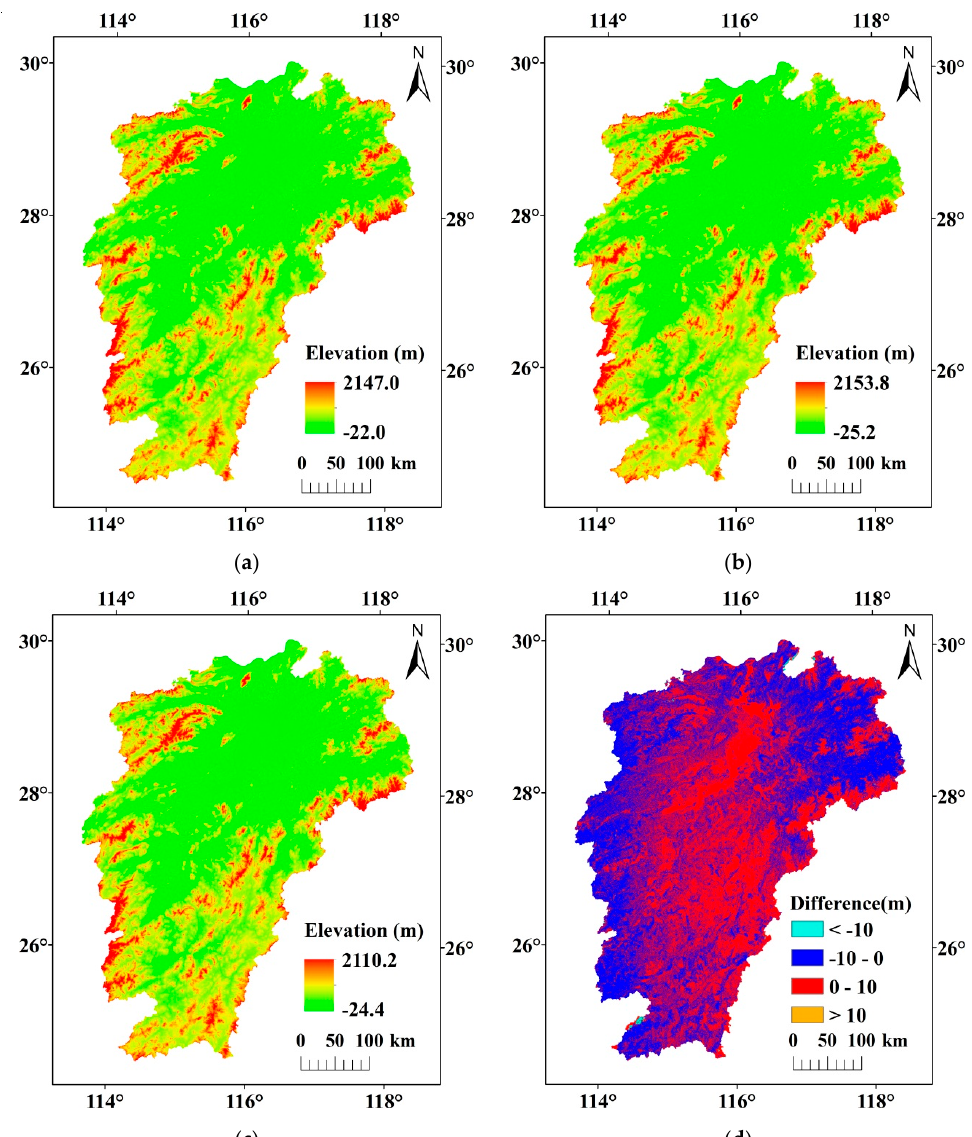
Figure 11. ( a ) Original SRTM3 DEM, ( b ) DEM corrected by MLR, ( c ) DEM corrected by RF, and ( d ) RF-based DEM minus MLR-based DEM.